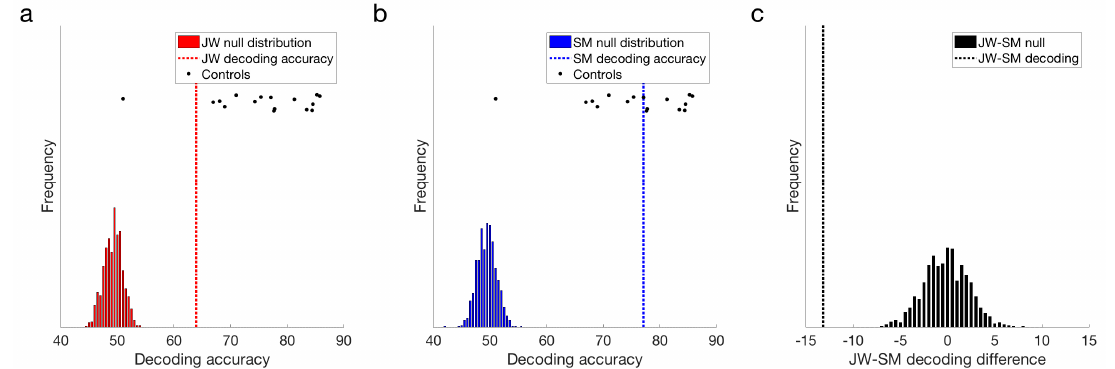
Figure 4. Frequency domain decoding results. ( a ) JW and ( b ) SM compared with their null distributions and individuals in the control group. Dotted lines designate the obtained classification accuracy for that patient. ( c ) Difference in decoding accuracy between JW and SM compared with the difference in the null distributions. JW’s frequency domain decoding was significantly lower than SM’s, p = 0.001. Note the single control outlier in the control